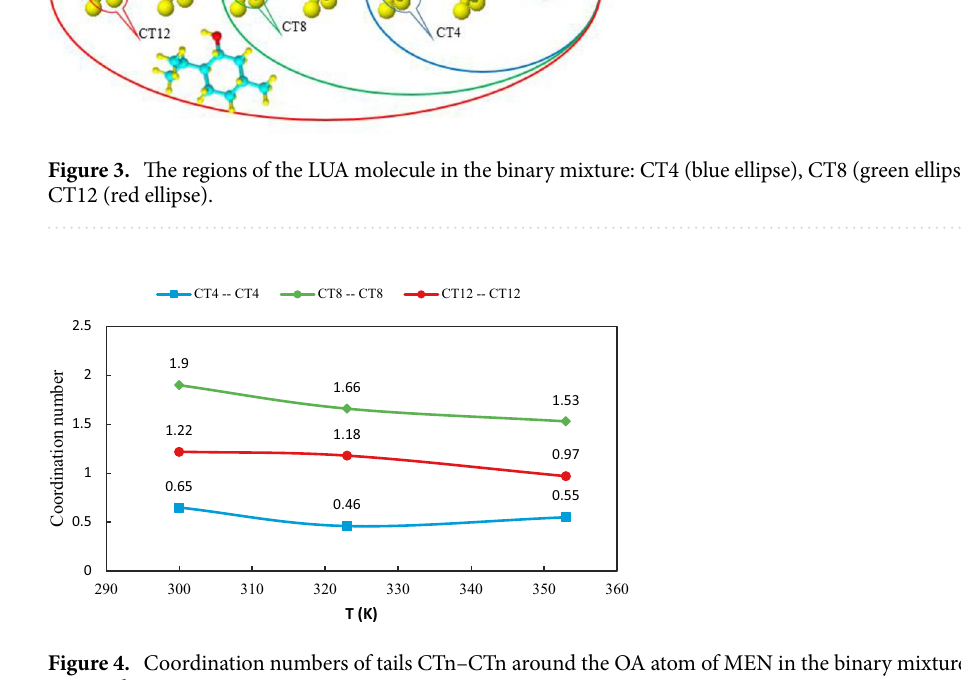
Figure 4. Coordination numbers of tails CTn–CTn around the OA atom of MEN in the binary mixtures of LUA and